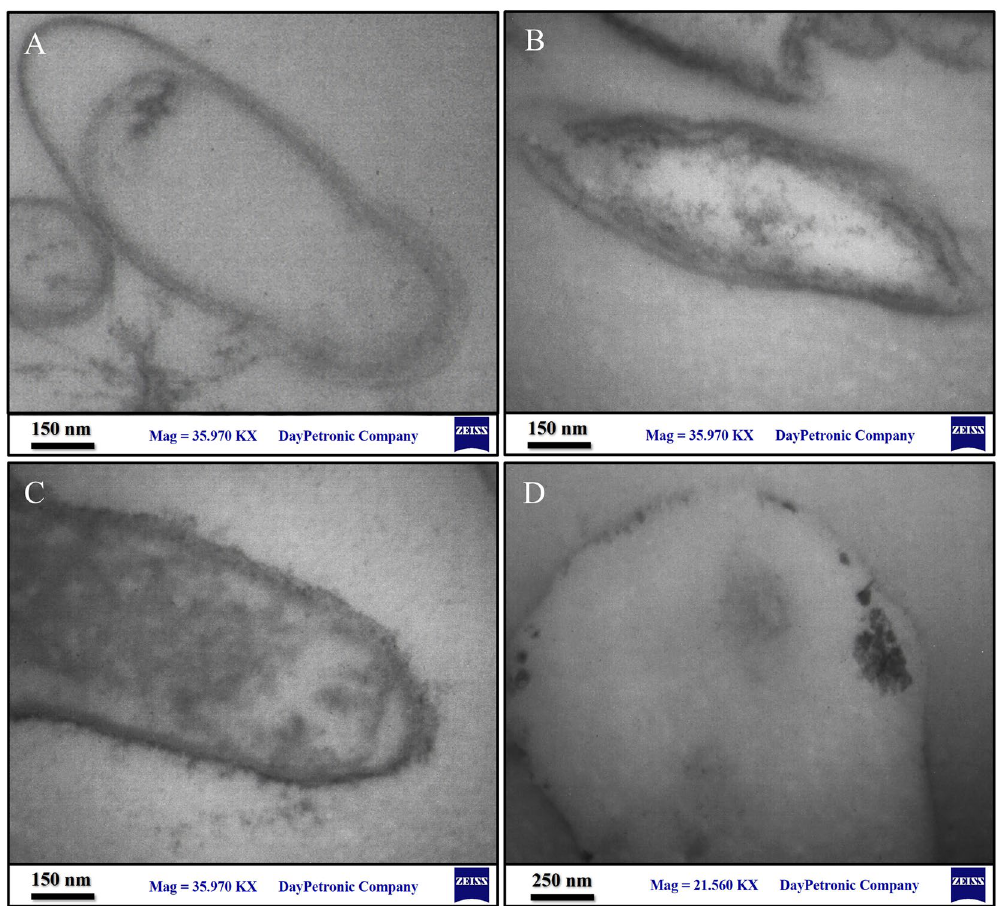
Figure 4. Transmission electron micrograph of A. sobria grown in heavy metal-supplemented NB medium for 24 h. ( a ) Cells free from metals (control); ( b ) supplemented with Cu; ( c ) supplemented with Ni; and ( d ) supplemented with